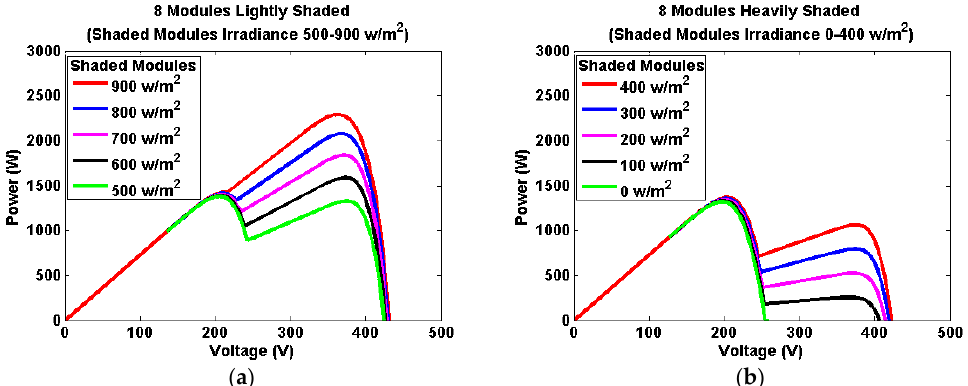
Figure 9. P-V characteristics of the 8 modules shaded setups: ( a ) shaded modules irradiance is between 500 and 900 w/m 2 ; ( b ) shaded modules irradiance is between 0 and 400 w/m 2 .